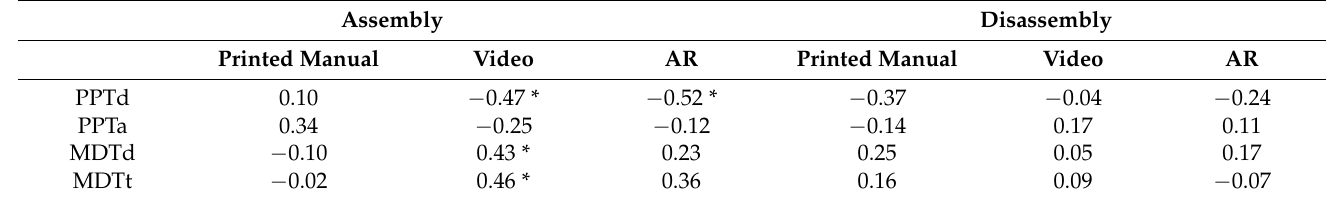
Table 5. Pearson’s correlation coefficients between time to complete the task and hand dexterity test score.